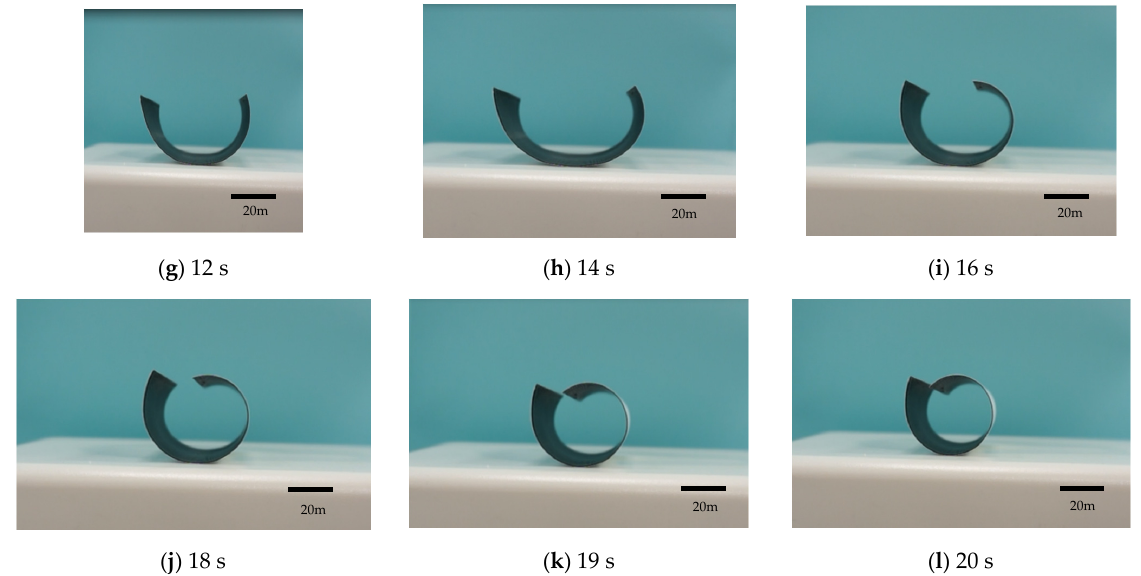
Figure 7. Deformation angles of the stimulus-responsive composite material with various heating times (at a heating temperature of 190 °C and heating time of 0~20 s).